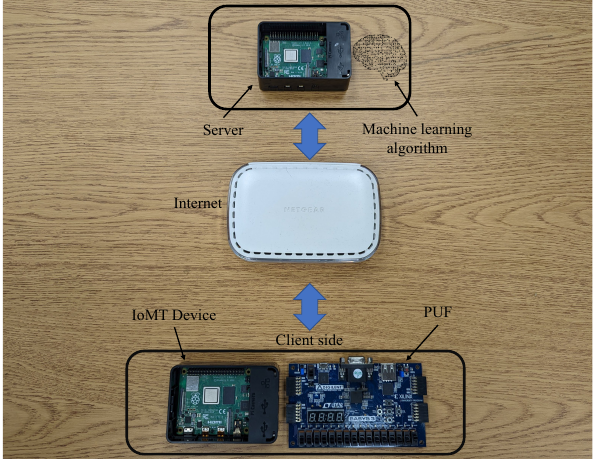
Figure 9. Experimental setup.